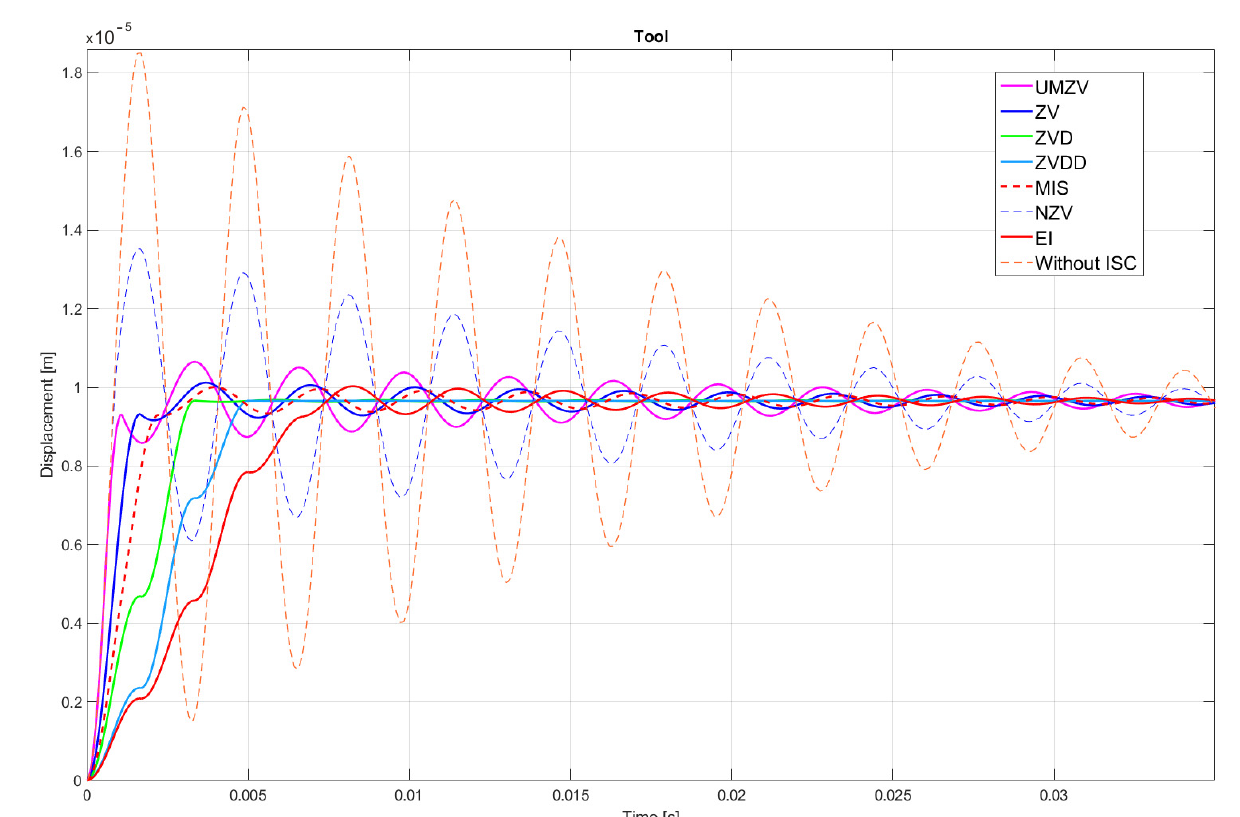
Figure 8. Tool displacement during finishing machining: without ISC control, using UMZV, ZV, ZVD, ZVDD, MIS, SNA and EI algorithm.